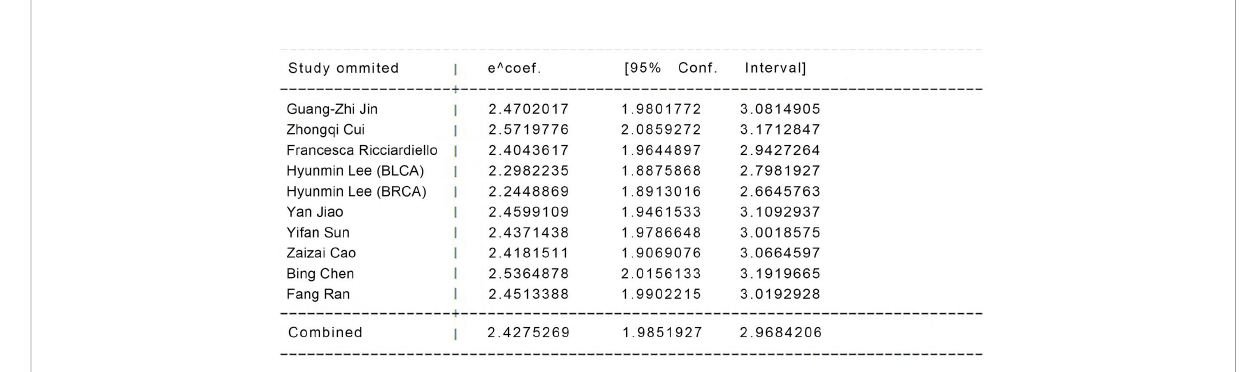
FIGURE 5 Speci fi c data for sensitivity analysis between groups to the